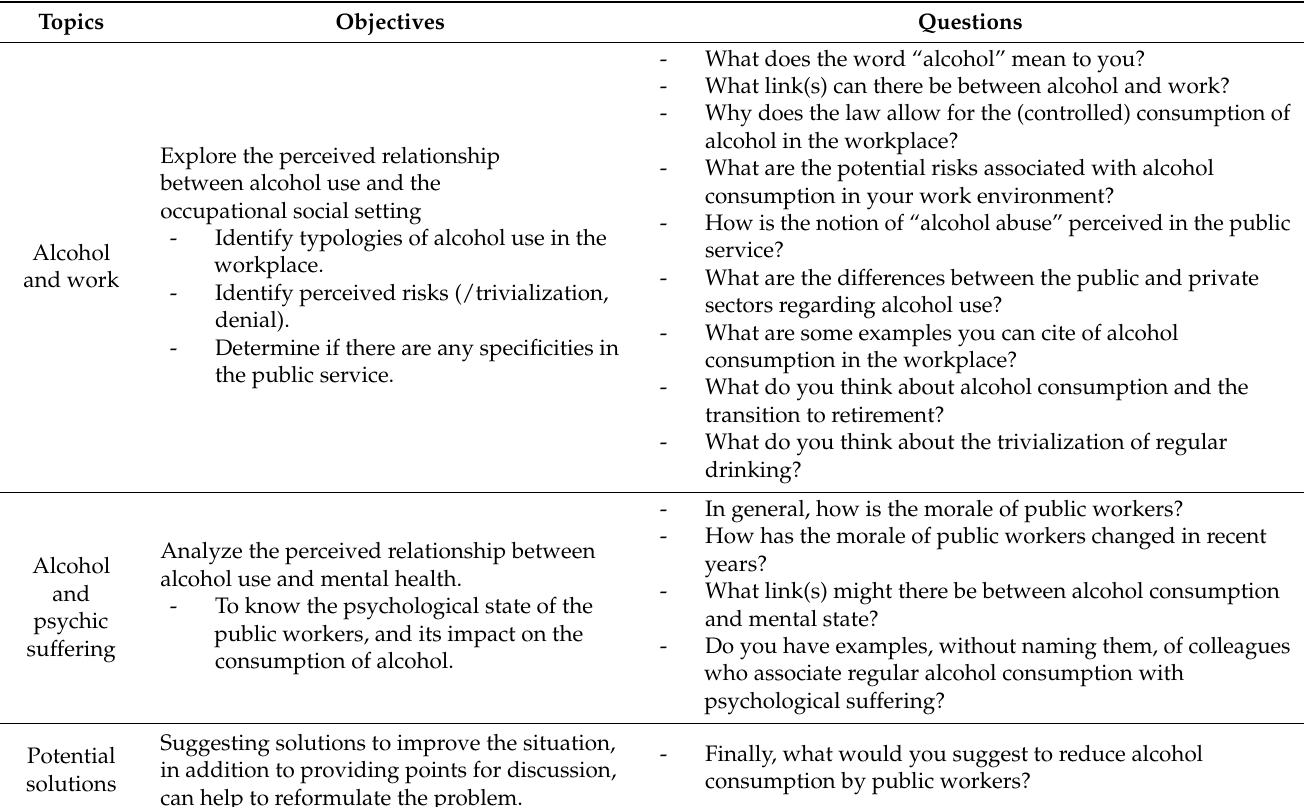
Table 1. Interview